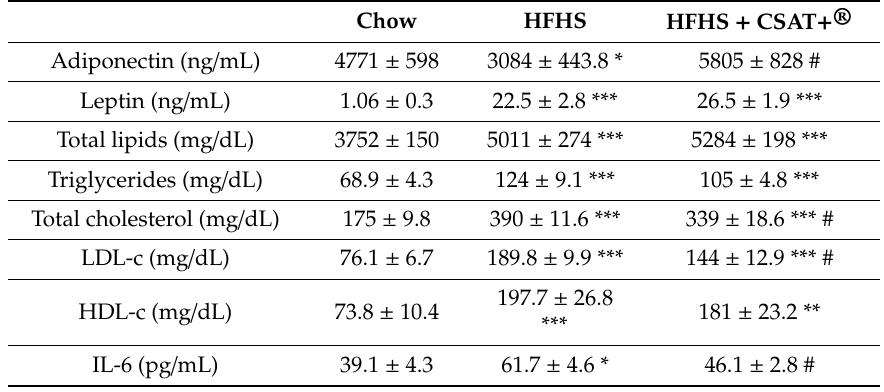
Table 3. Plasma levels of adiponectin, leptin, total lipids, triglycerides, total cholesterol, low-density lipoproteins (LDL)-cholesterol, high-density lipoproteins (HDL)-cholesterol, and interleukin-6 (IL-6) of mice fed either a standard diet (chow) or a high fat / high sucrose diet (HFHS) supplemented or not with CSAT + ® for 26 weeks. Data are represented as mean ± SEM. ( n = 12 mice / group). * p < 0.05 vs. chow; ** p < 0.01 vs. chow; *** p < 0.001 vs. chow; # p < 0.05 vs. HFHS. Chow HFHS HFHS + CSAT + ® Adiponectin (ng /